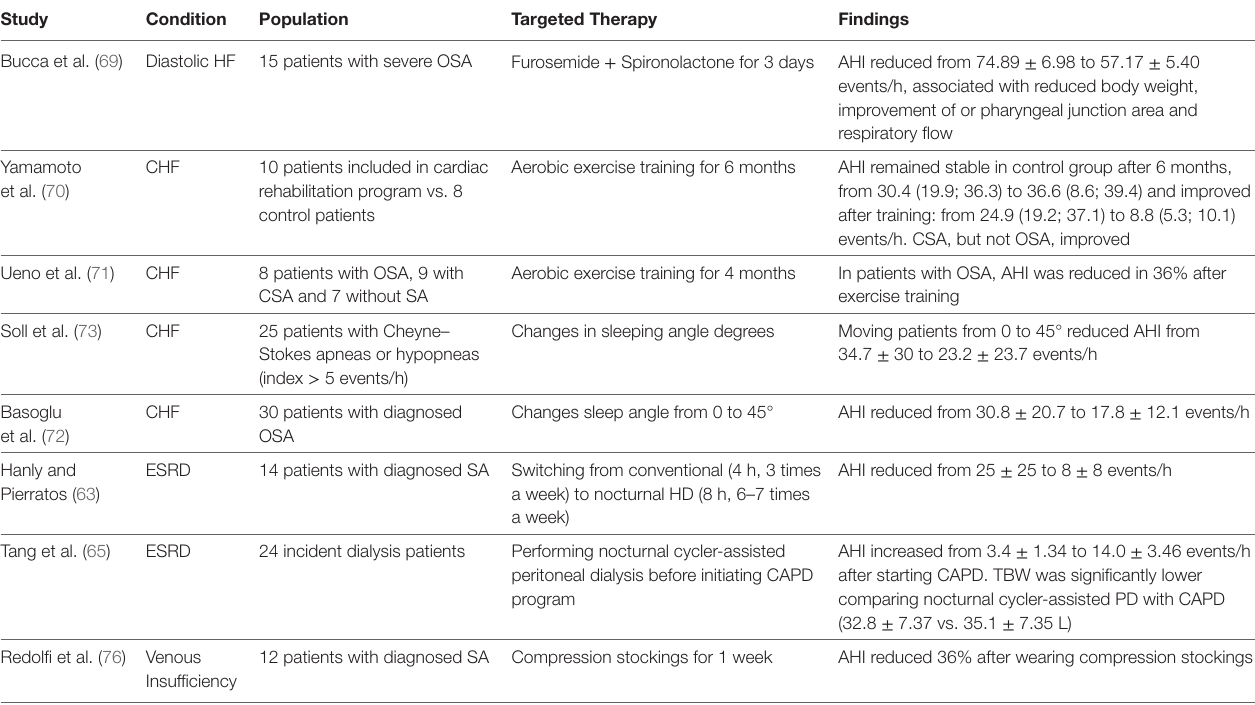
FiGURe 2 | Flowchart of suggested therapeutic interventions to alleviate fluid shift in four different clinical scenarios: congestive heart failure, venous insufficiency, nephrotic syndrome, and chronic kidney disease. BP, blood pressure; HD, hemodialysis; PD, peritoneal dialysis; APD, automatic peritoneal dialysis.